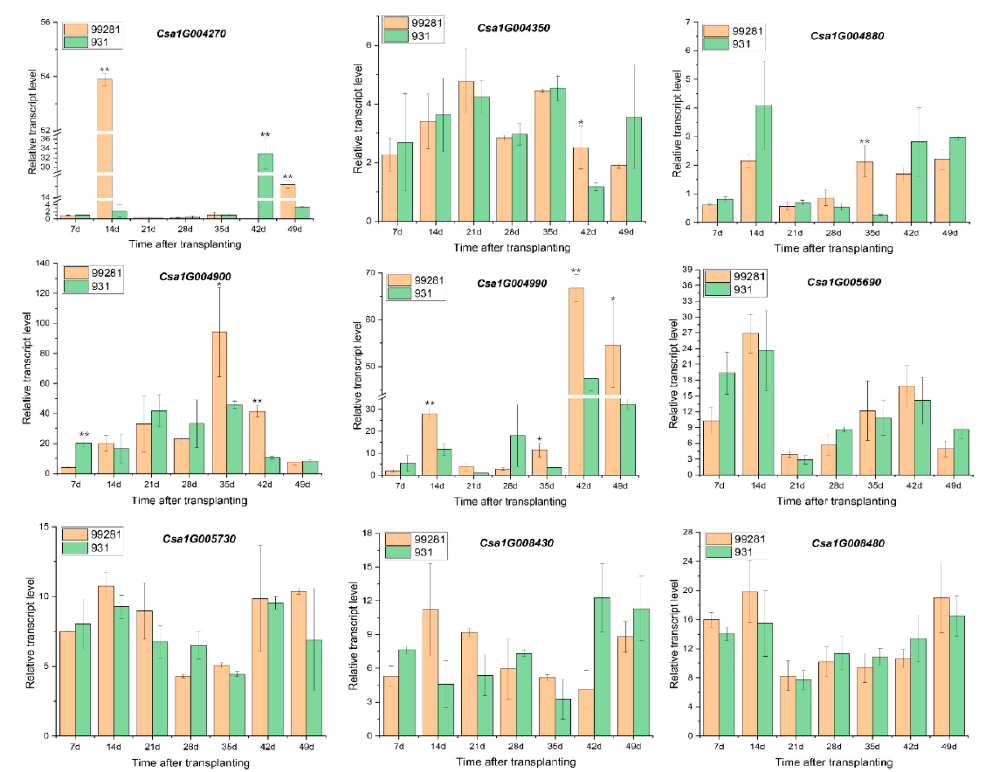
Figure 8. Relative quantitative expression analysis of candidate genes. The data represent the relative expression levels of genes at different time-points in “99281” and “931”. Actin1 was set as the internal reference gene. The error bars represent the standard error of three biological replicates. The seven time-points before (7d, 14d, 21d, 28d, 35d after transplanting) and after (42d and 49d after transplanting) heat stress of “99281” and “931” correspond to the seven columns in the histogram. The asterisks indicate that there were significant differences in expression level between “99281” and “931” (* 0.01 < p < 0.05; ** p < 0.01).